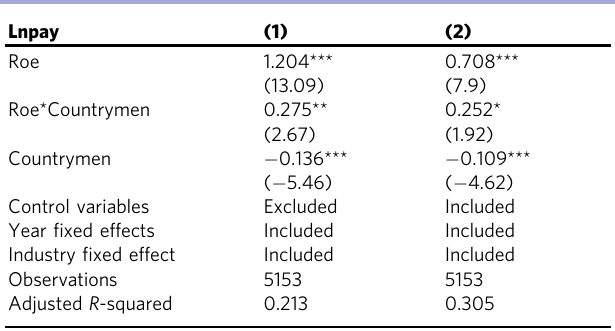
The OLS method uses the pooled regression while controlling for industry and year effects. The t -statistics are shown in parentheses. Beta coef fi cients are indicated at the 1%, 5%, and 10% levels of signi fi cance by ***, **, and *, respectively. Table 8 In fl uence of family relationship.